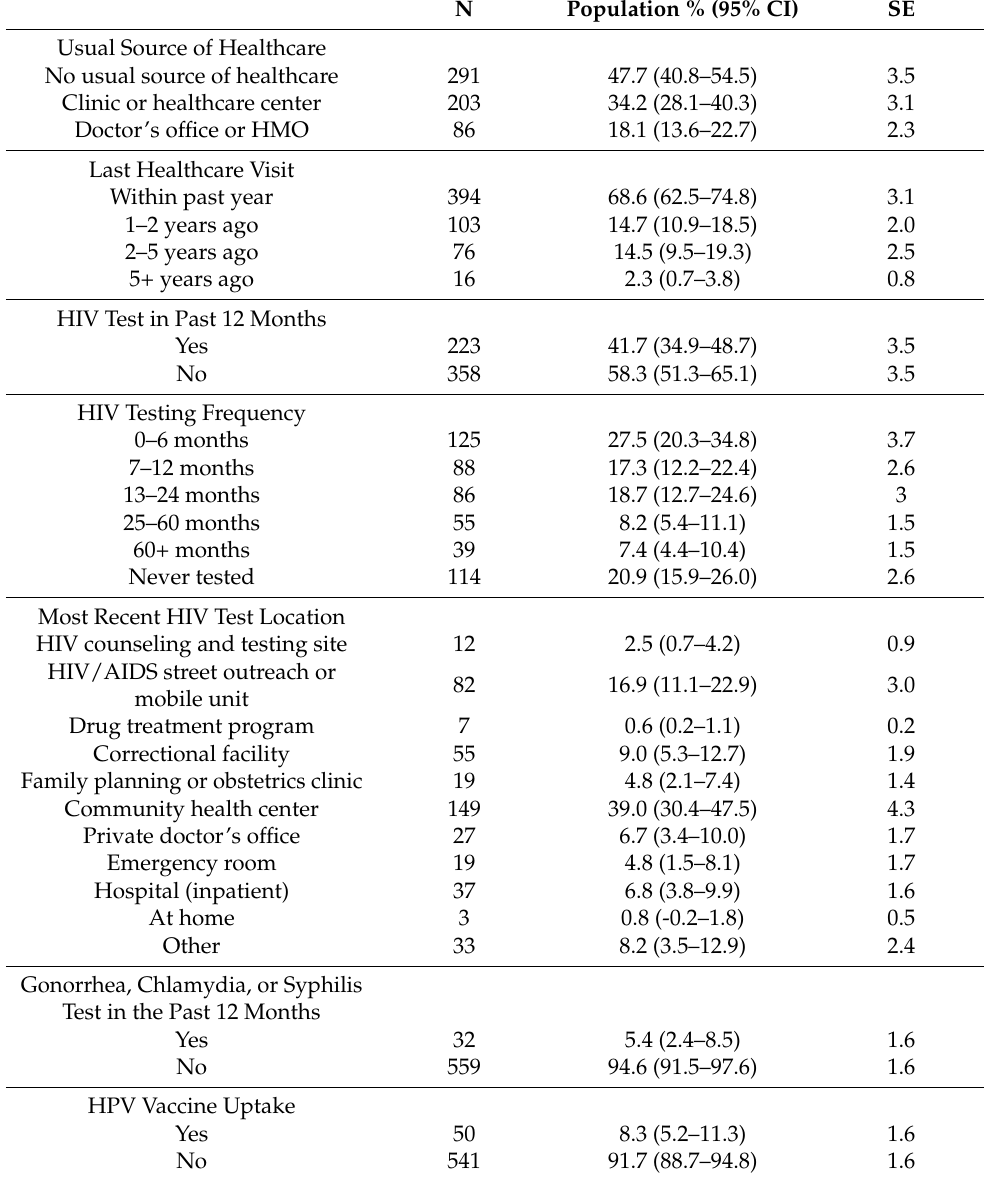
Table 2. Testing behaviors and primary care utilization among the study